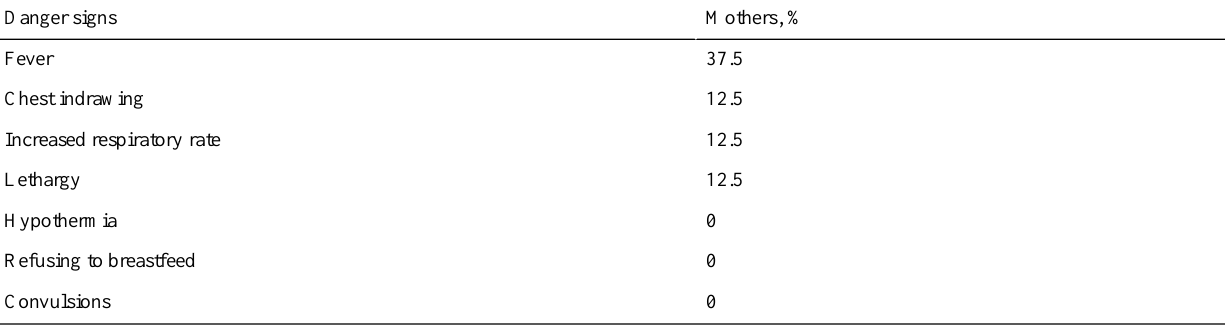
Table 3. Mothers’recall of neonatal danger signs in study phase two